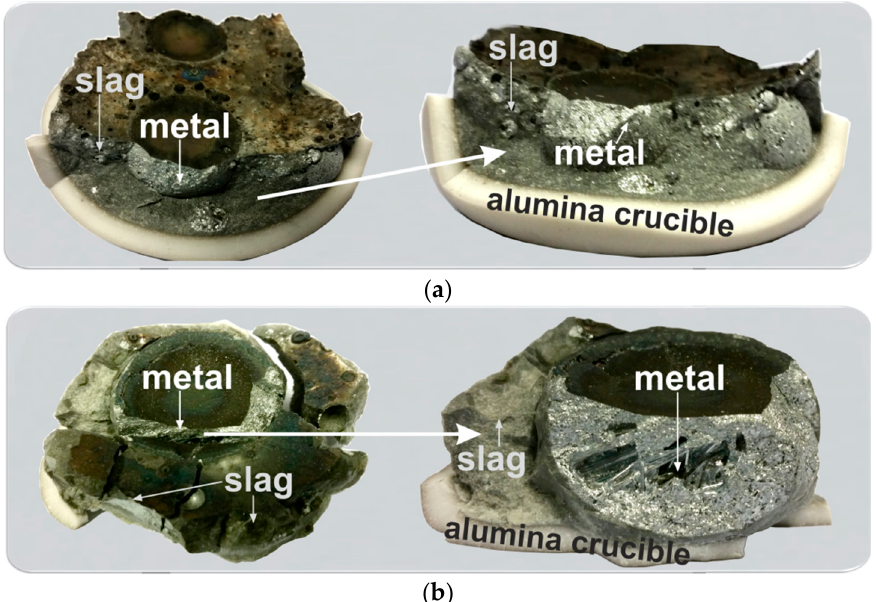
Figure 7. The broken crucibles after experiments 3 ( a ) and 4 ( b ).